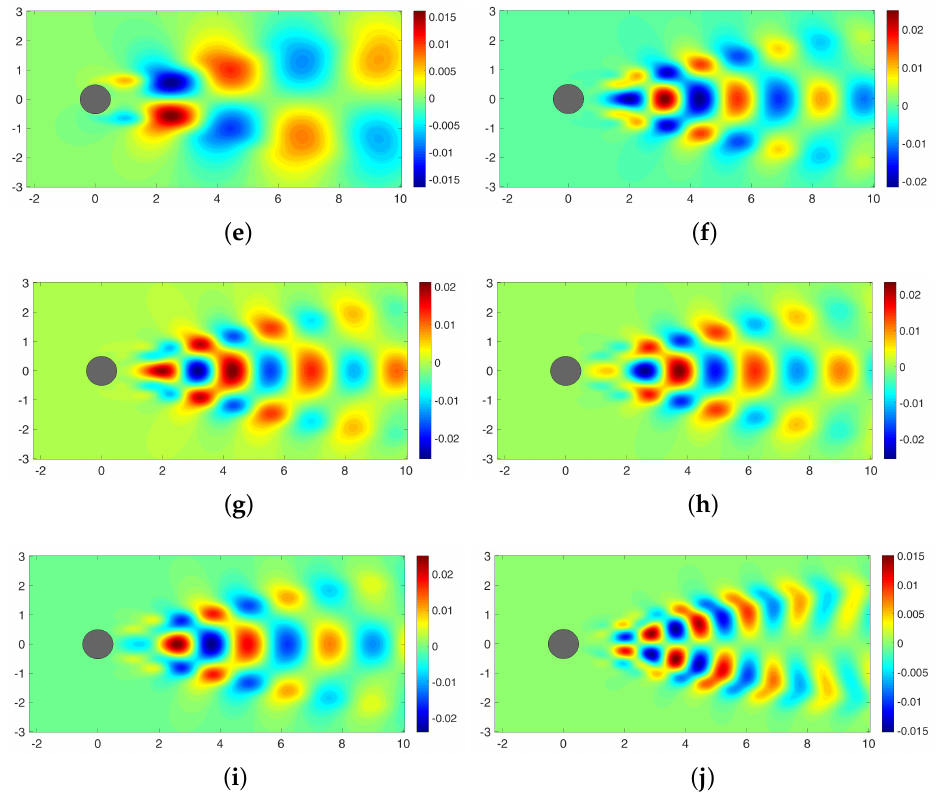
Figure A4. Isocontours of first five POD modes with and without removing the mean from the snapshot data for cylinder wake flow with Re = 100. ( a ) 1st POD mode (with mean); ( b ) 1st POD mode (without mean); ( c ) 2nd POD mode (with mean); ( d ) 2nd POD mode (without mean); ( e ) 3rd POD mode (with mean); ( f ) 3rd POD mode (without mean); ( g ) 4th POD mode (with mean); ( h ) 4th POD mode (without mean); ( i ) 5th POD mode (with mean); and ( j ) 5th POD mode (without mean).